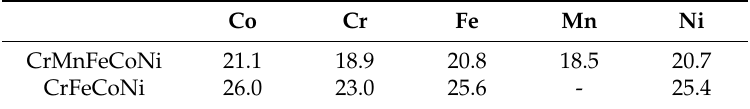
Table 4. Average chemical composition of CrMnFeCoNi and CrFeCoNi in as-cast condition measured by X-ray fluorescence (XRF; main alloy elements in relative wt